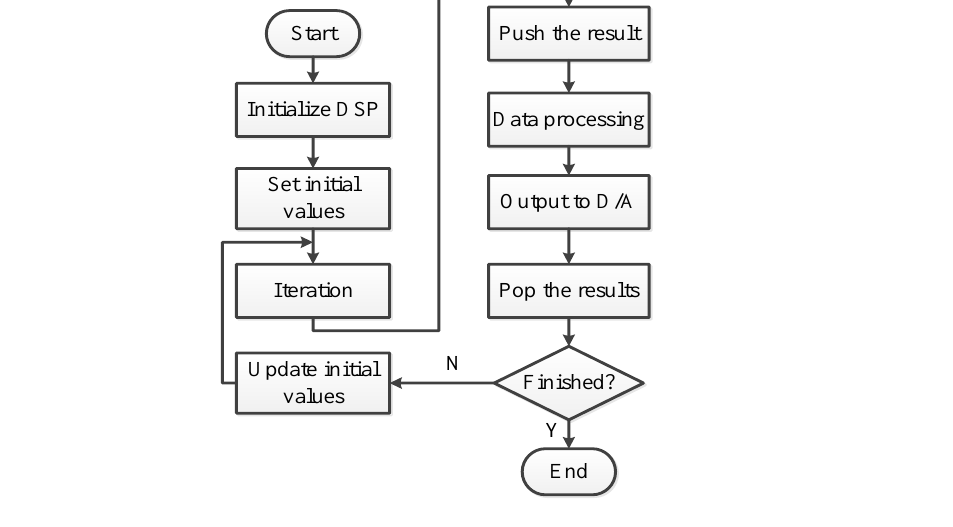
Figure 12. Flowchart for DSP implementation program.